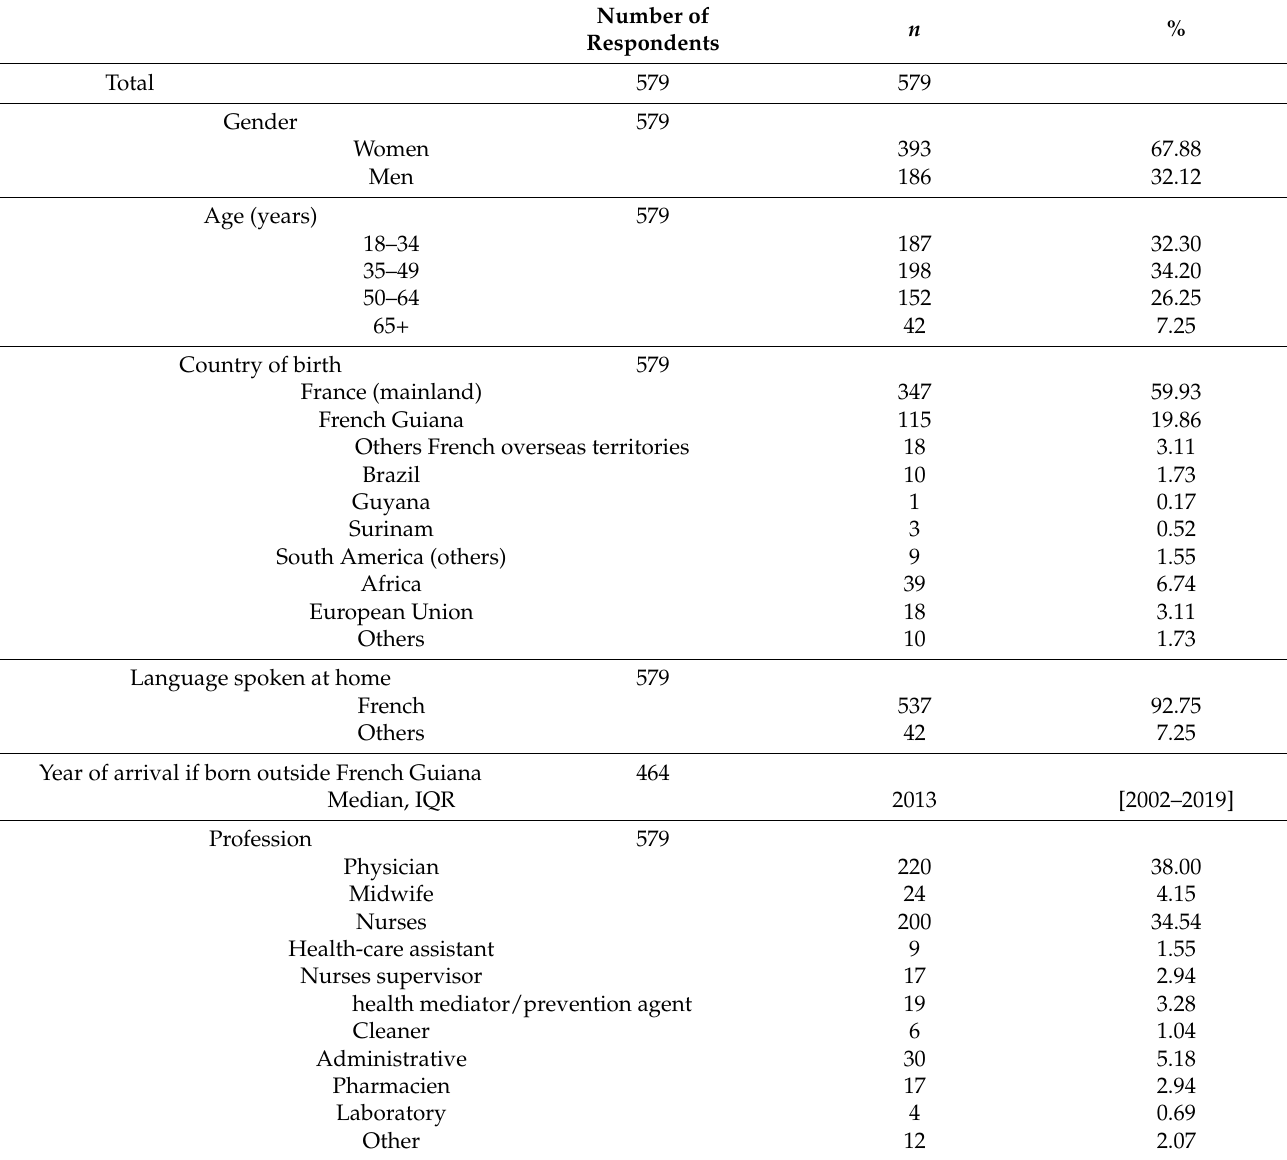
Table 1. Characteristics of